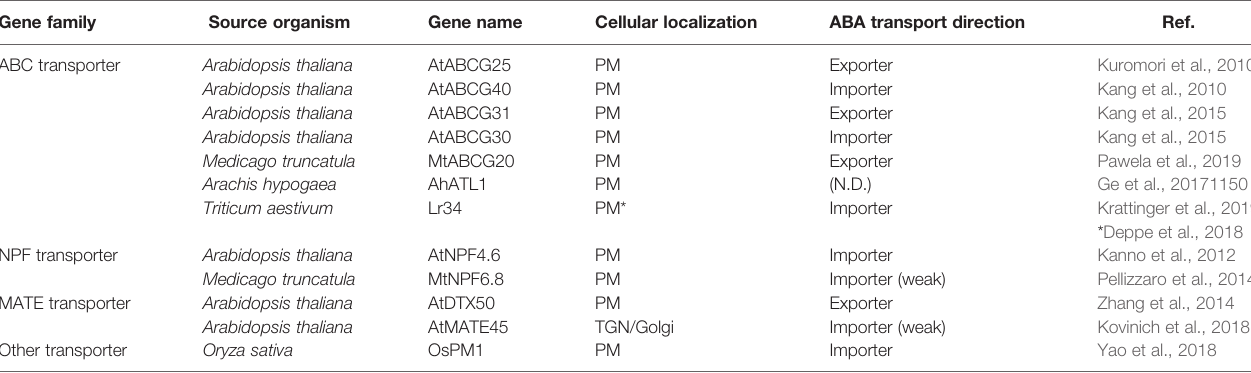
TABLE 1 | Summary of membrane transporters reported as ABA